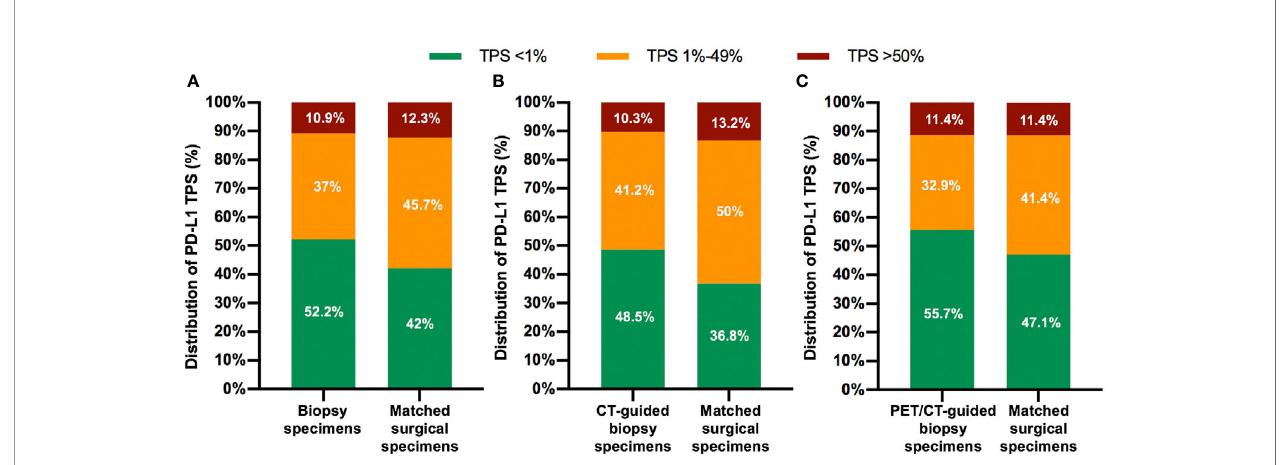
FIGURE 1 | Distribution of PD-L1 Tumor Proportion Score (TPS) for both biopsy specimens and matched surgical specimens in the overall patient population (A) , in the CT-guided biopsy group (B) , and in the PET/CT-guided biopsy group (C) .